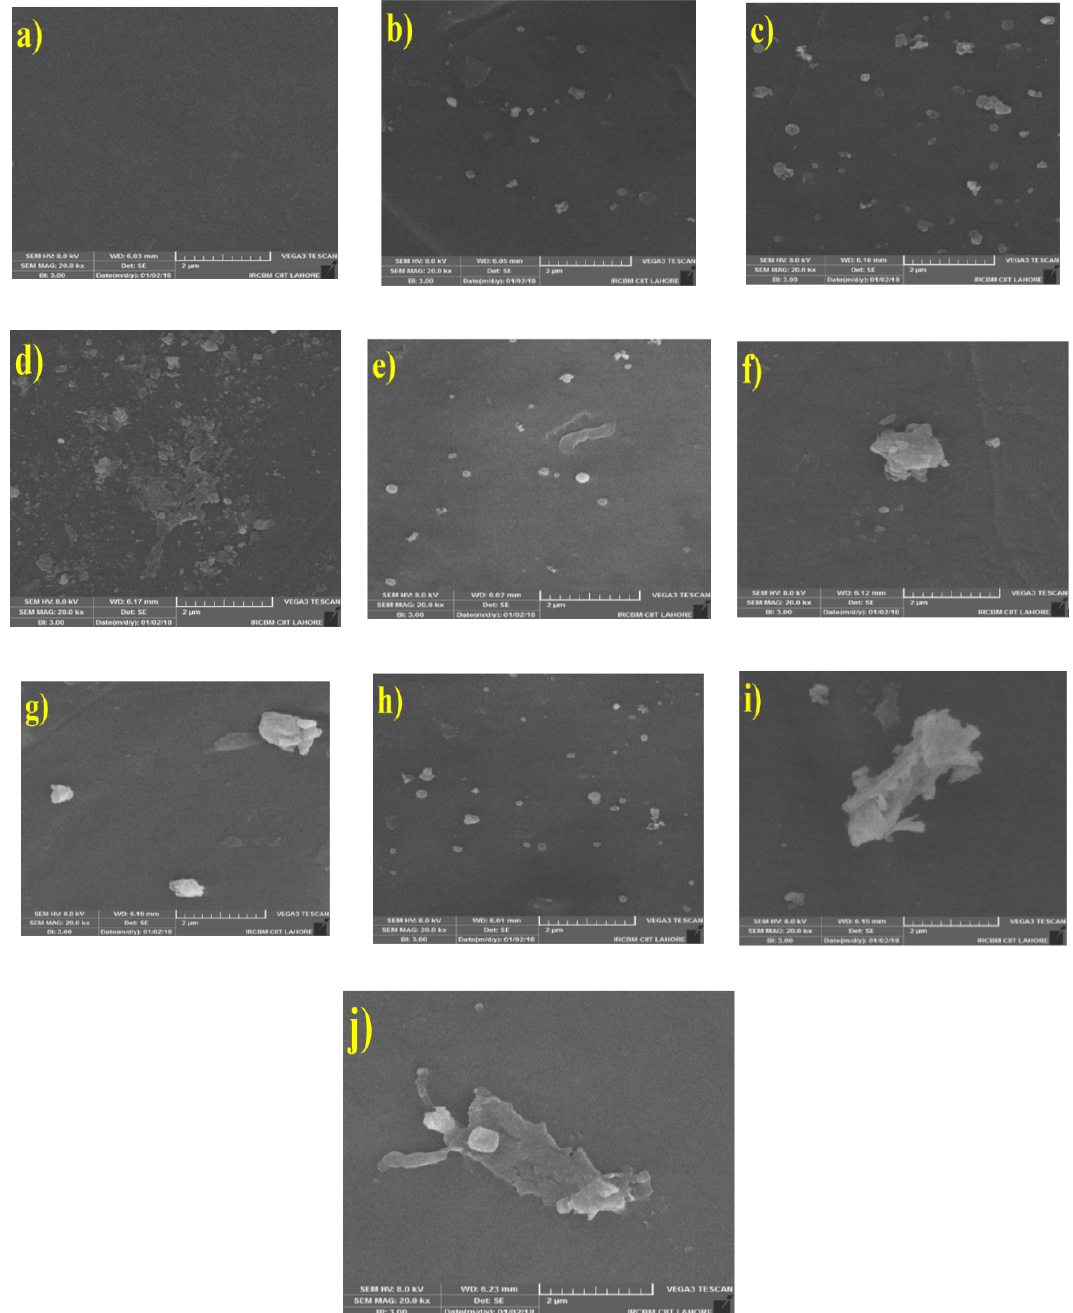
Figure 1. Surface SEM images of membranes ( a ) Neat PSf membrane; ( b – d ) PSf/Zeolite 4A membranes; ( e – g ) PSf/UiO-66 membranes; ( h – j ) PSf/Zeolite 4A-UiO-66 membranes with different nanofiller loadings (0.5 wt%, 1 wt%, 2 wt%, respectively).